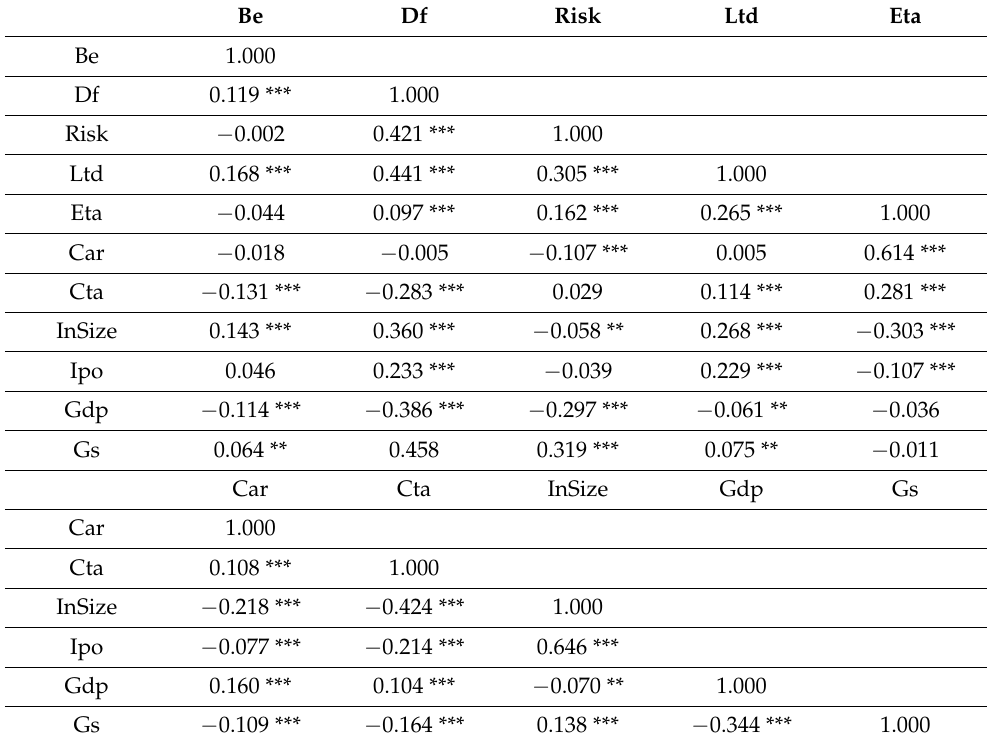
Table 4. Correlations of